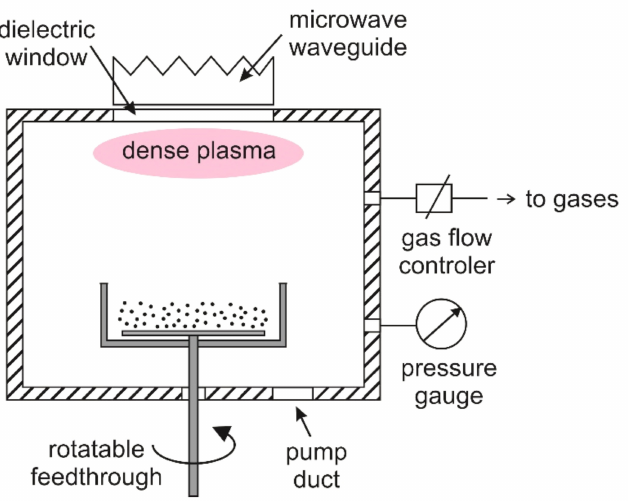
Figure 1. Schematic of the experimental setup for the treatment of PE